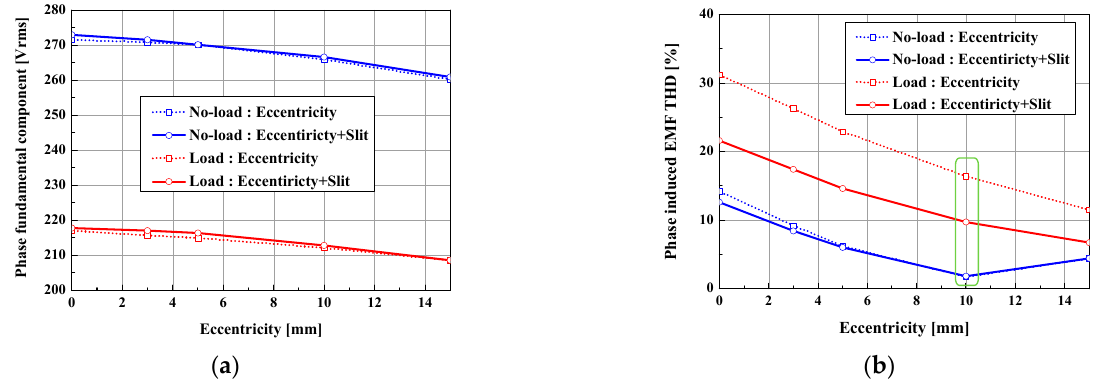
Figure 10. Comparison of the induced EMF at no-load and load drives for the two proposed models: ( a ) fundamental component, and ( b ) THD.